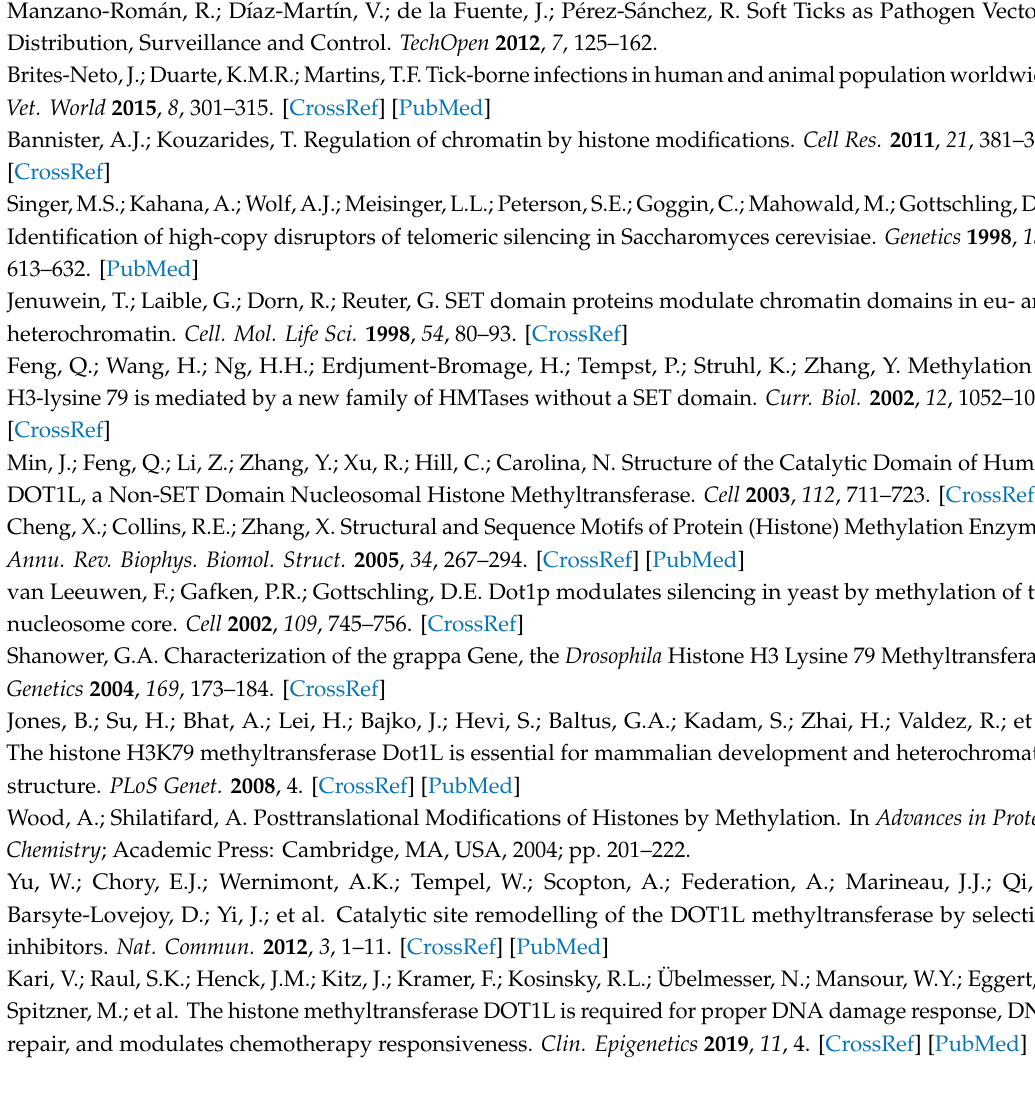
Figure S1: Phylogenetic tree of DOT1L protein sequences of major taxonomic groups. OmDOT1L orthologues from di ff erent taxa were collected from GenBank and aligned. The best-fit model of the sequence evolution was predicted to be the LG-model. Maximum likelihood method was used to obtain the best tree topologies and a proportion of Gamma distribution sites was estimated. The reliability of internal branches was assessed using the bootstrapping method (1000 bootstrap replicates). Interestingly, not all Ixodidae DOT1L sequences clustered together, but some clustered with ticks of the Argasidae family, Figure S2: Alignment of the catalytic domain of DOT1L sequences included in the phylogenetic tree. Conserved, and less conserved, residues of S-adenosylmethionine (SAM) binding sites are highlighted in yellow and green,